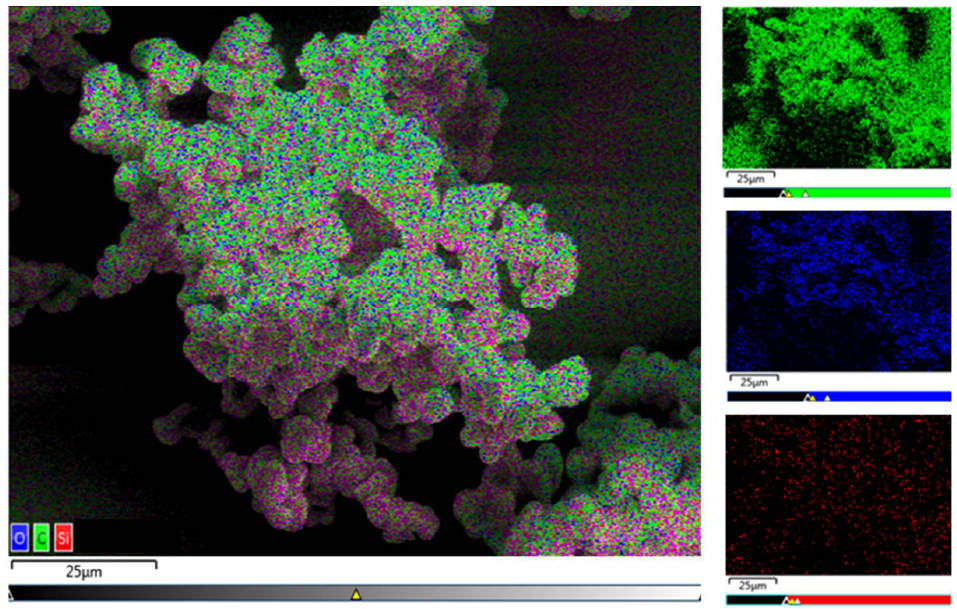
Figure 3. SEM-EDX overlay image and single images of elemental distribution within a TIPS- functionalized RF xerogel.